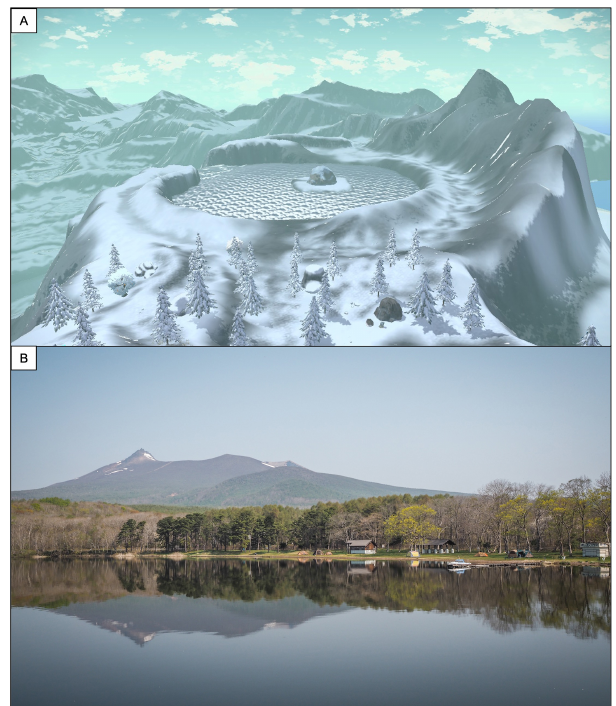
Figure 7. Comparison image of in-game and real-world inspira- tion. (a) Lake Acuity, Alabaster Iceland, a high-seat, crater-like lake with a central island in Pokémon Legends: Arceus (Fig. 1a7) ©The Pokémon Company International (2022a). (b) Photograph of Lake Onuma, Hokkaido (Fig. 1b7). Lake Onuma does not have a central island (Thompson,